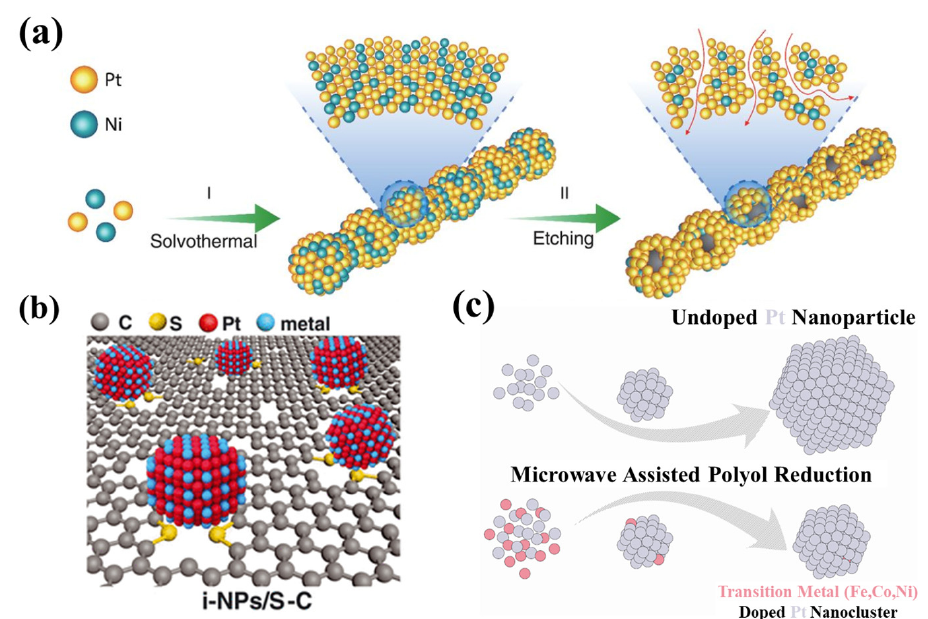
Figure 2. Catalyst performance enhancement through alloying, ordering, and doping: ( a ) Synthesis route and structure of PtNi alloy. Reprinted with permission from Ref. [30]. Copyright 2019, AAAS. ( b ) Diagram of the sulfur-anchored ordered alloy method. Reprinted with permission from Ref. [31]. Copyright 2021, AAAS. ( c ) Schematic of transition metal doping method. Reprinted with permission from Ref. [32]. Copyright 2022, John Wiley & Sons.